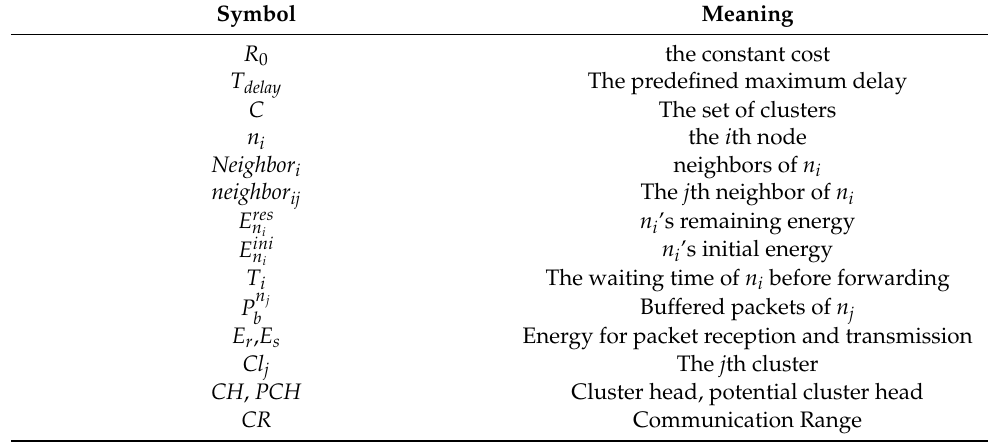
Table 1. List of